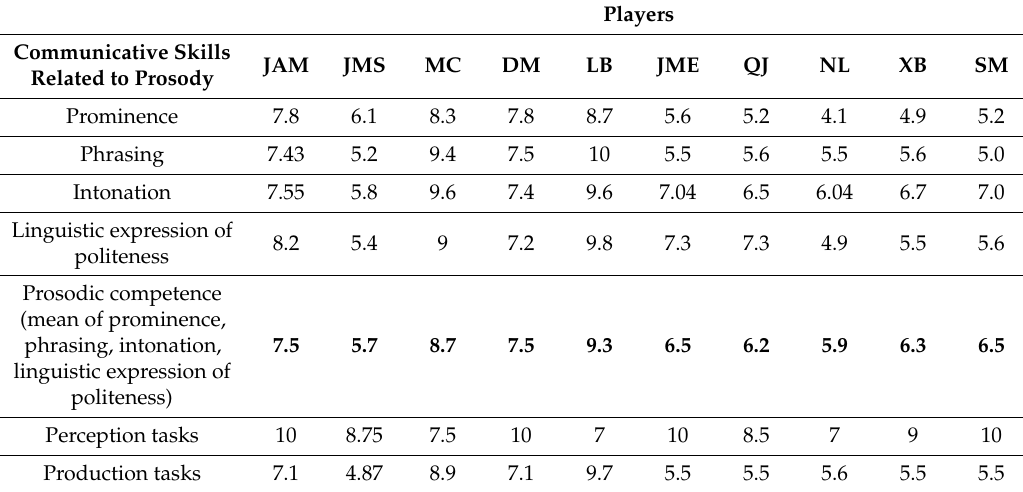
Table 3. Scores obtained by each of the players in communicative skills related to prosody and in the domains of speech comprehension and